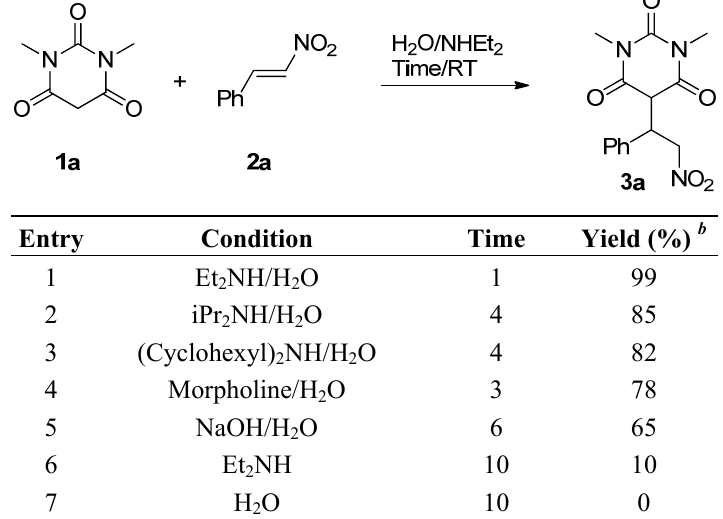
Table 1. Screening of conditions for the Michael addition reaction of the model substrate a .